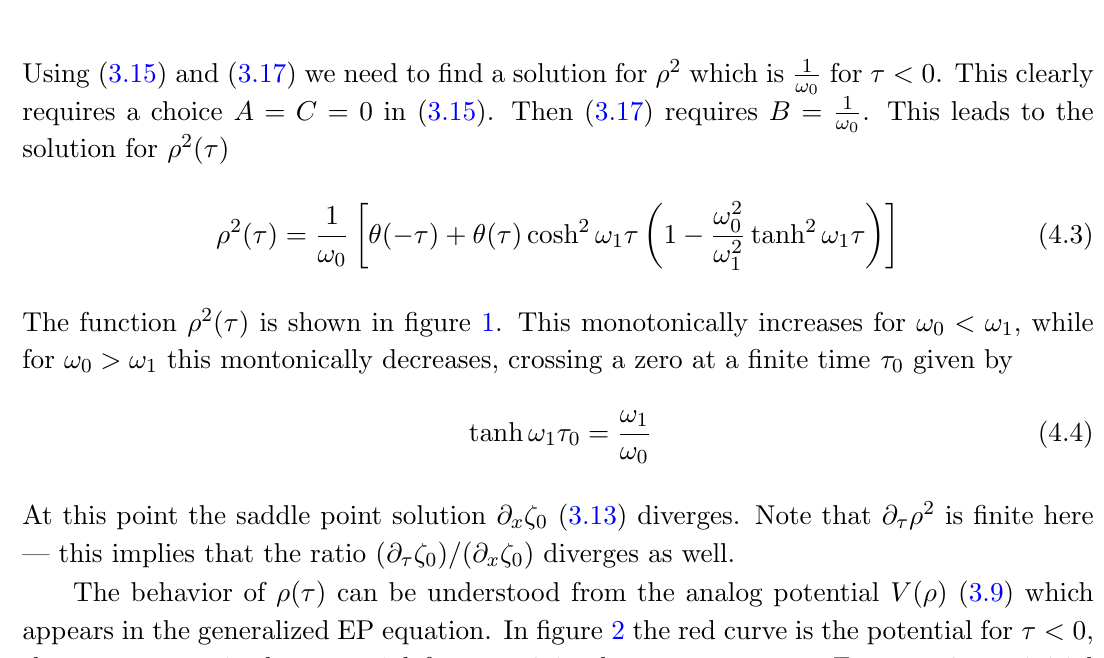
Figure 1. (cid:26) 2 ( (cid:28) ) for abrupt quench. We have chosen ! 0 = 1. The green line has ! 1 = p the blue line has ! 1 = 1 =